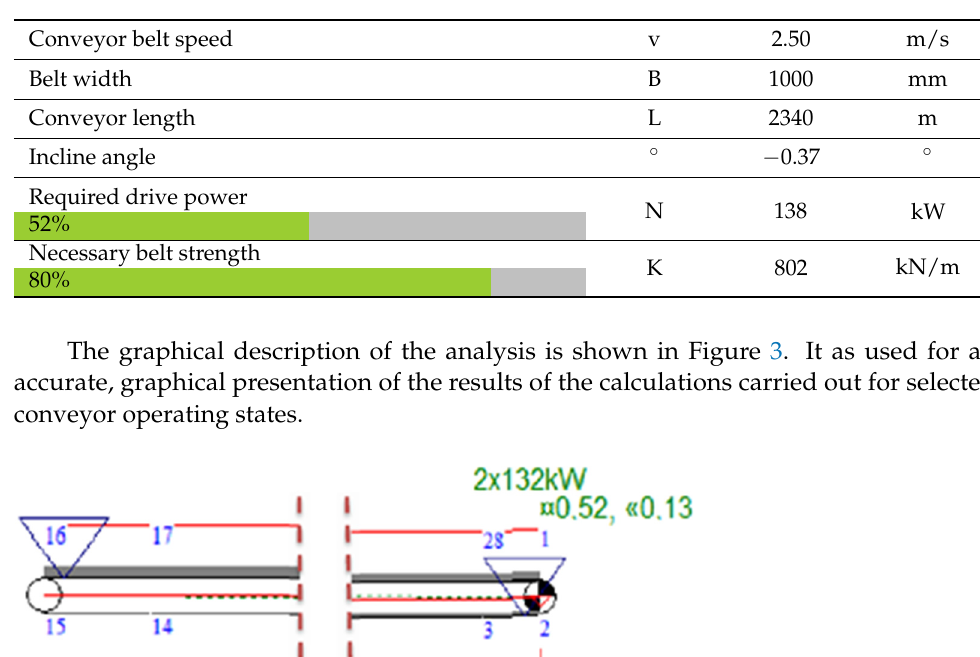
Table 3. Basic parameters and results of conveyor verification calculations.